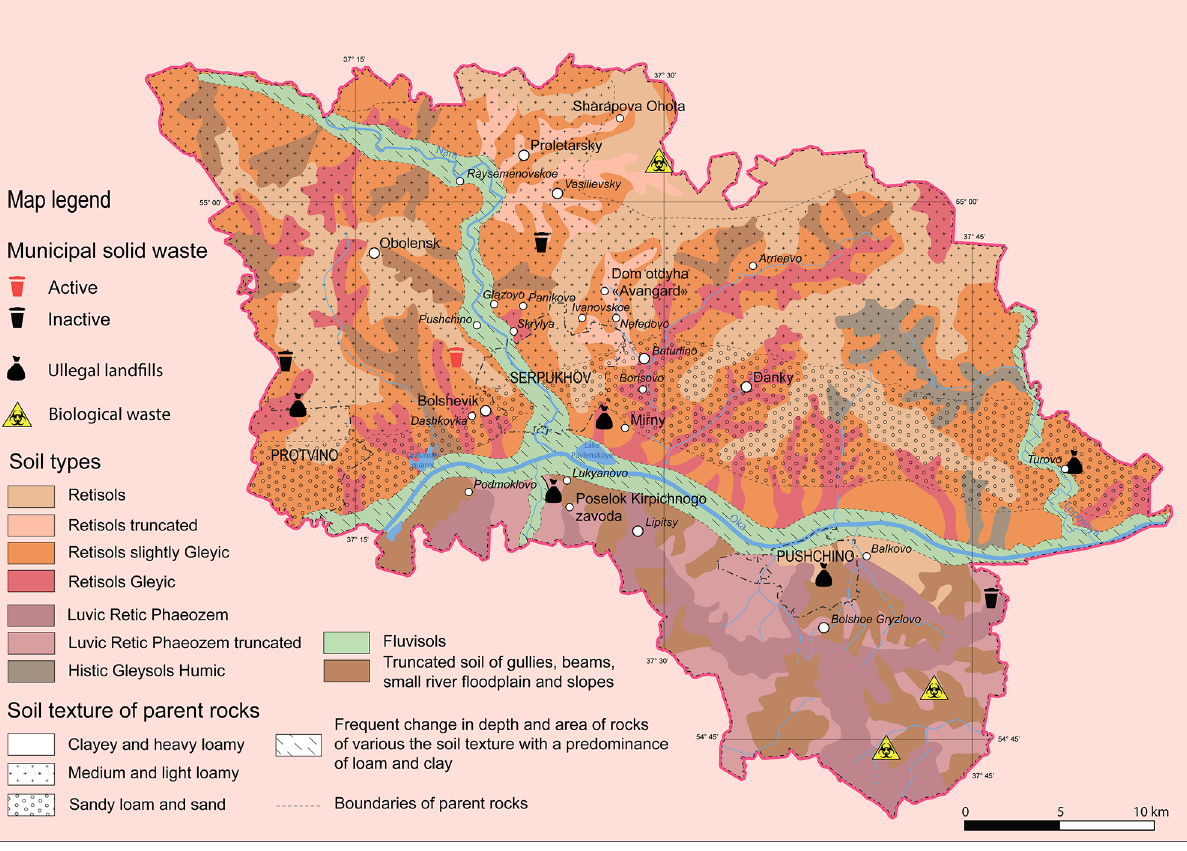
Figure 3. The map “Landfills in the Serpukhov